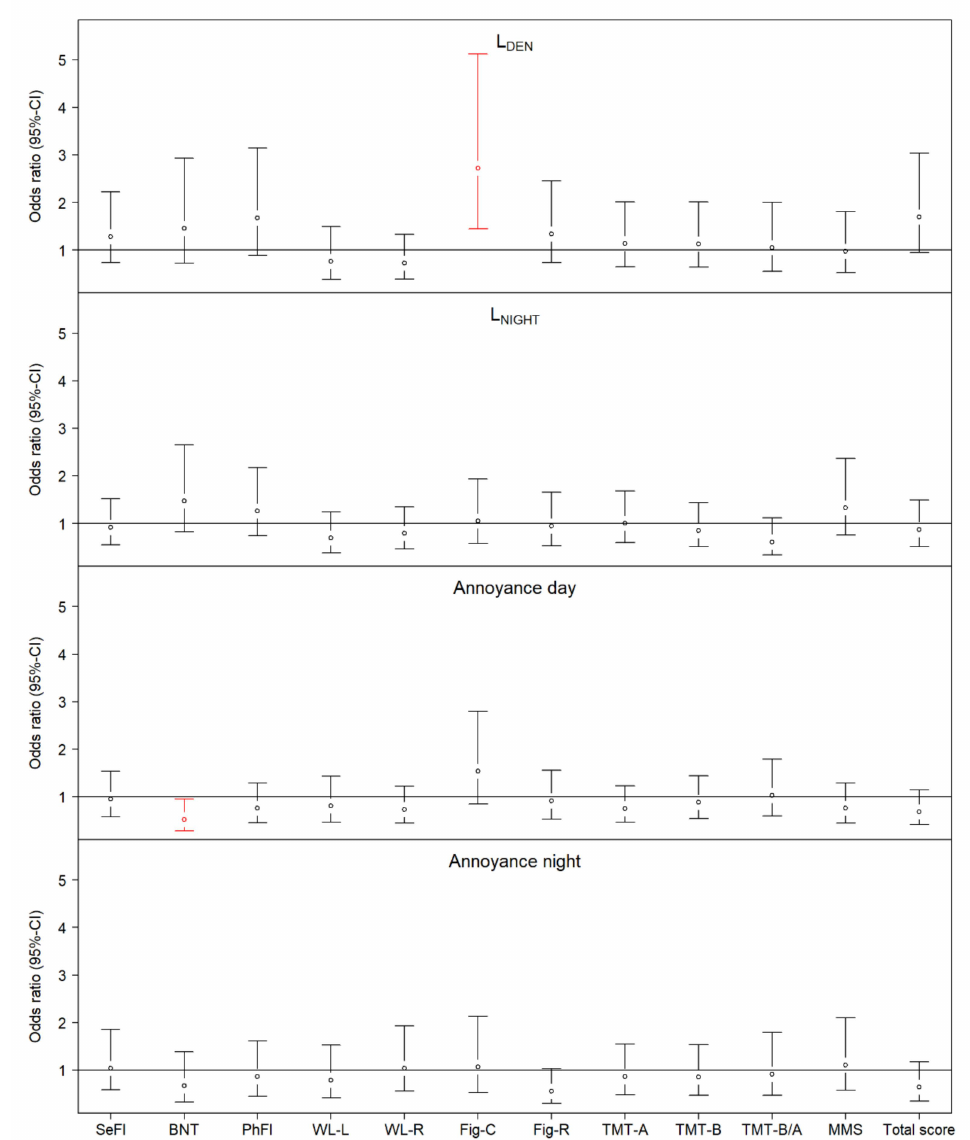
Figure 2. Association of residential noise and noise annoyance with dichotomized cognitive scores. Adjusted for age (linear, squared, and cubic terms), smoking, passive smoking, and educational level. We modeled the probability that score < 0 (cognitive performance lower than expected for the participant’s age and educational level). Statistically significant associations ( p < 0.05) are marked